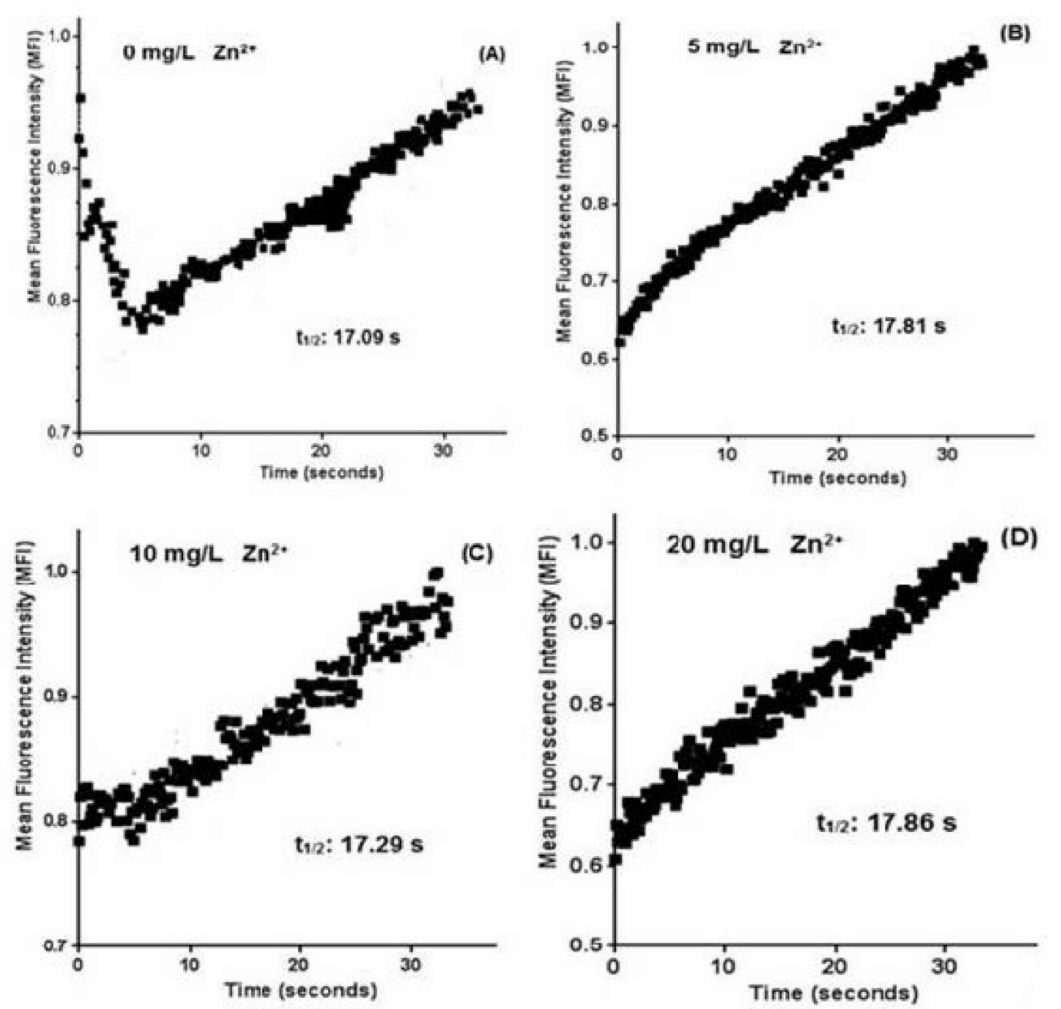
Figure 5. Analysis of fluorescence recovery after photobleaching (FRAP) in autofluorescence of native pigments in microalgae Tetraselmis marina AC16-MESO, at different concentrations of Zn 2+ after 72 h of exposure. ( A ) 0 mg L − 1 ; ( B ) 5 mg L − 1 ; ( C ) 10 mg L − 1 ; ( D ) 20 mg L − 1